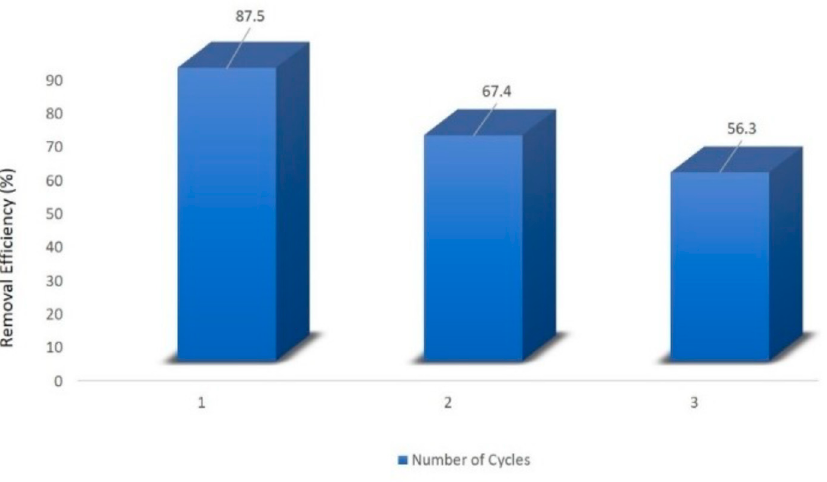
Figure 12. Regeneration process of the modified polyacrylonitrile. Adapted with permission from reference [128].